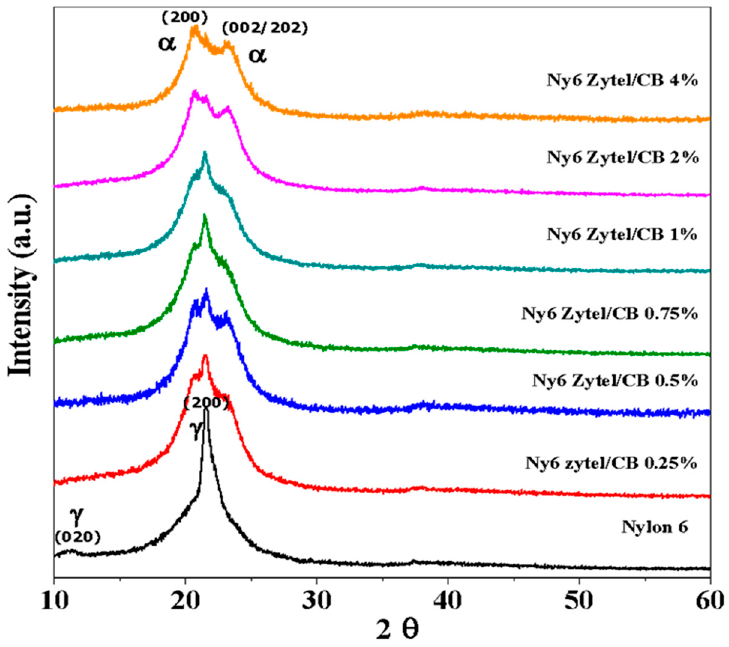
Figure 1. X-ray diffraction patterns of Nylon 6 nonwoven fabric and Ny6 Zytel/CB nonwoven fabric at different concentrations of MCBNs (0.25, 0.5, 0.75, 1.0, 2.0, and 4.0%).